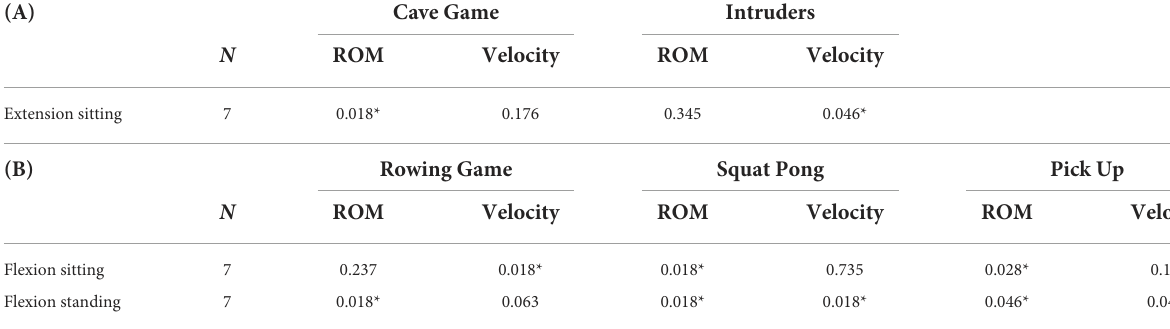
ROM,Kneejointrangeofmotion;Velocity,Angularvelocity. * Wilcoxonsignedranktestp < 0.05.